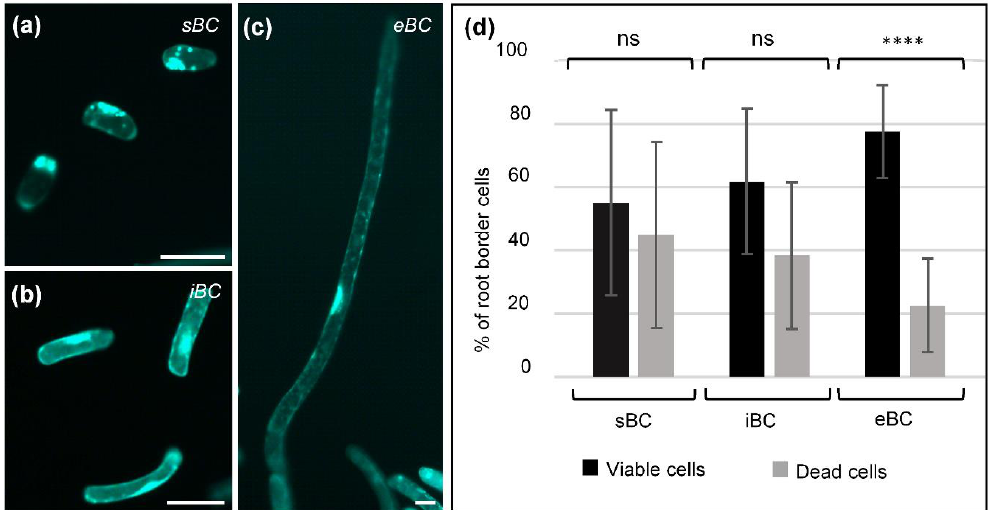
Figure 3. Cell viability. ( a – c ) Fluorescence images showing viable cells of the three BC morphotypes: ( a ) spherical; ( b ) intermediate; and ( c ) elongated. ( d ) Histograms represent quantitative data indicating the relative proportion of viable and non-viable cells for each morphotype. Each histogram represents the means of 12 biological replicates. (Mann–Whitney test used; ns, not significant; **** P ≤ 0.0001). Cell viability was assessed using Fluorescein diacetate (FDA) as described by Plancot et al. [45]. sBC, spherical border cells; iBC, intermediate border cells; eBC, elongated border cells. Scale bar: 50 µm.